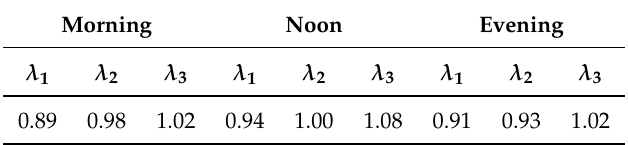
Table 11. The recommend settings for the typical lighting